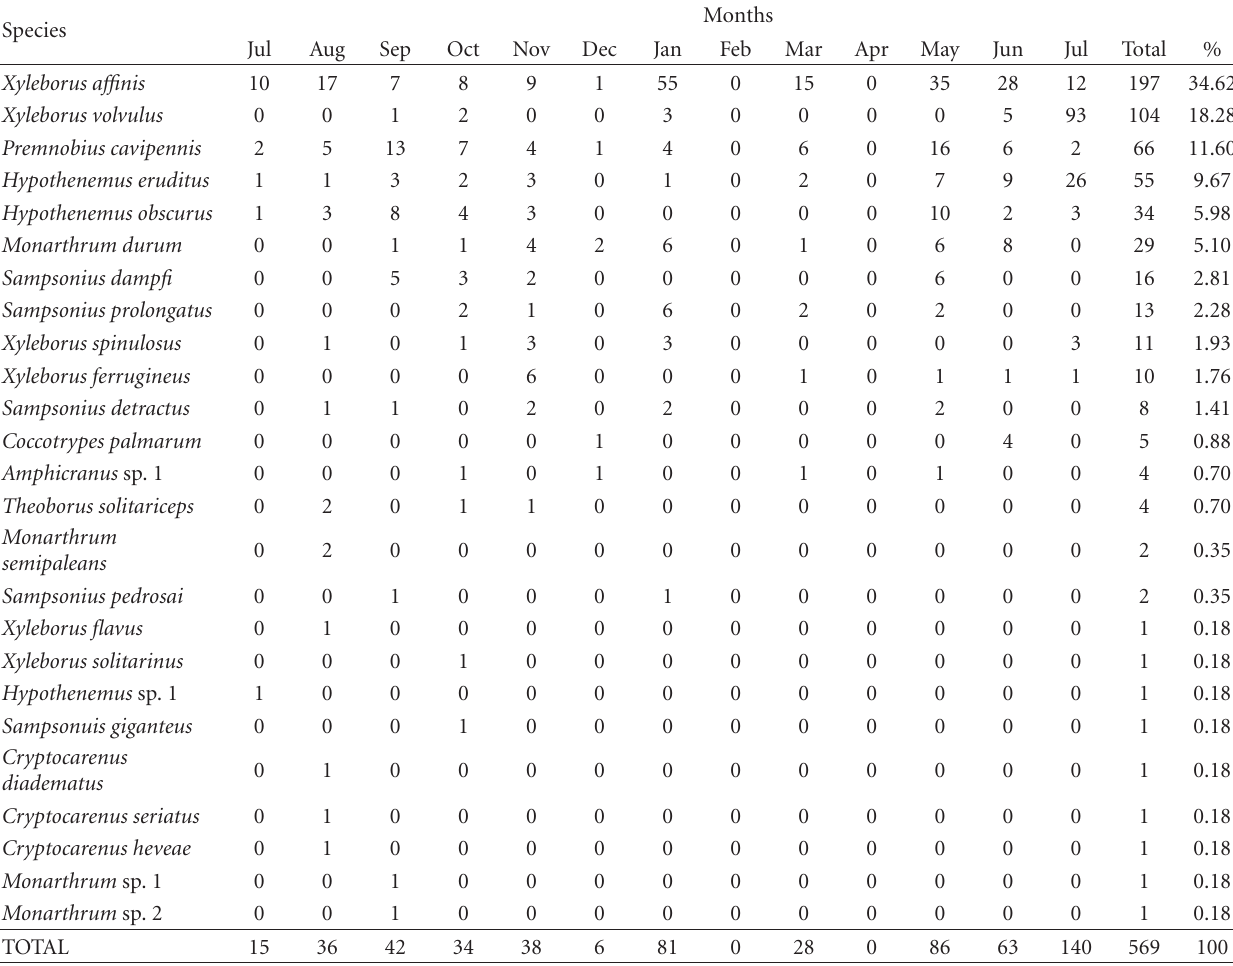
Table 2: Absolute and relative abundance of insects of the subfamily Scolytinae collected with Escolit´ıdeo/Curitiba traps during the period of July 2005 to July 2006, in primary forest of Central